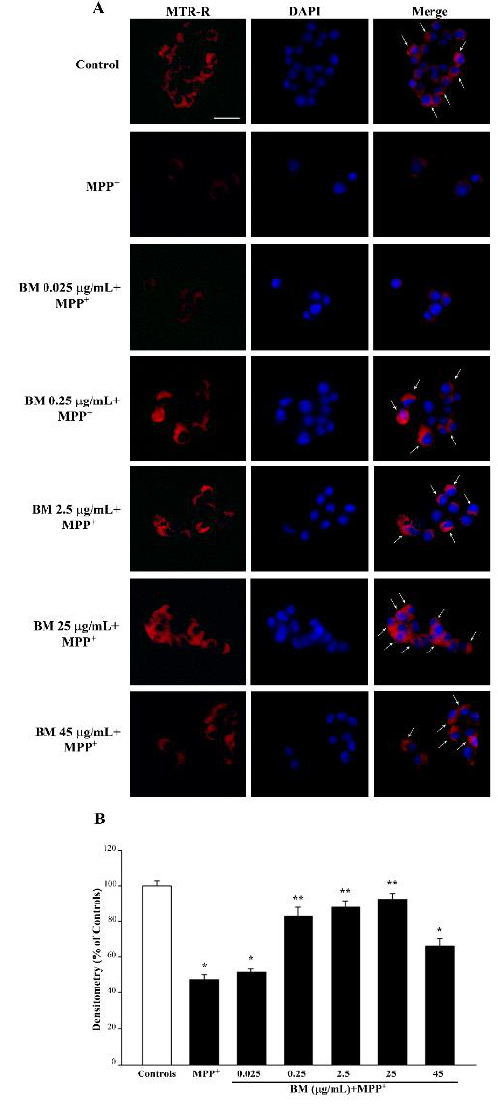
Figure 11. MitoTracker Red (MTR-R) fluorescent cells after combined administration of BM and MPP + . ( A ) Representative pictures of MTR-R fluorescence show that BM is protective against the reduction in MTR-R staining induced by MPP + . Arrows indicate intense MTR-R fluorescence. Cell nuclei are stained in blue with DAPI. ( B ) The graph reports the MTR-R fluorescence intensity. Note that the protective effect of BM against the MPP + -induced mitochondrial toxicity is already evident for the dose of 0.25 µ g/mL. Values are given as the mean percentage ± S.E.M. of optical density (assuming controls as 100%) from each experimental group from three independent